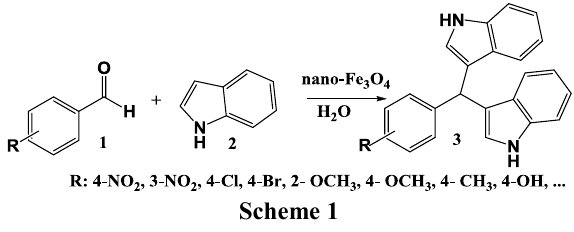
O for the synthesis of 3a 3 4